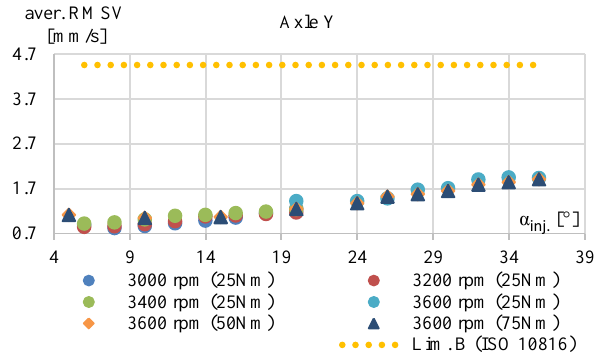
Fig. 15. Average RMS value of the vibration velocity depending on the injection angle for the Y axis (25, 50 and 75 Nm)